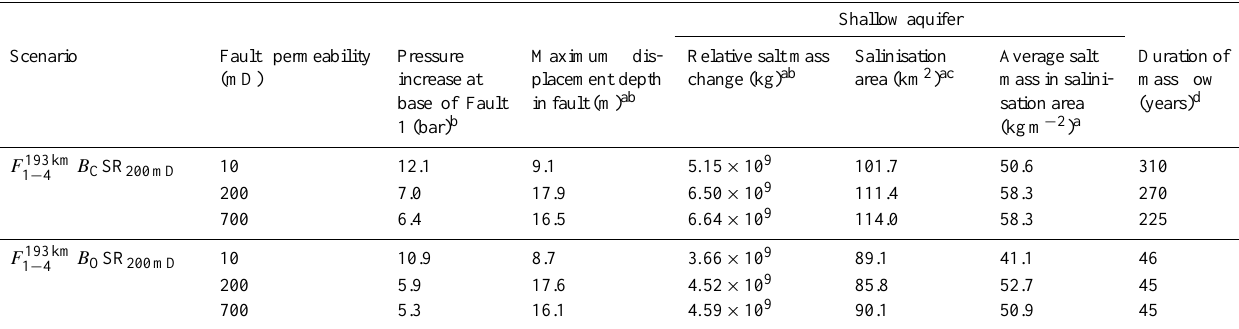
Table 4. Overview of six scenarios assuming a sharp saltwater–freshwater interface below the base of the shallow aquifer and a fault permeability of 10, 200 and 700mD. Maximum pressure increase at the base of Fault 1 and displacement depths in Fault 1 are again observed at the central part of the